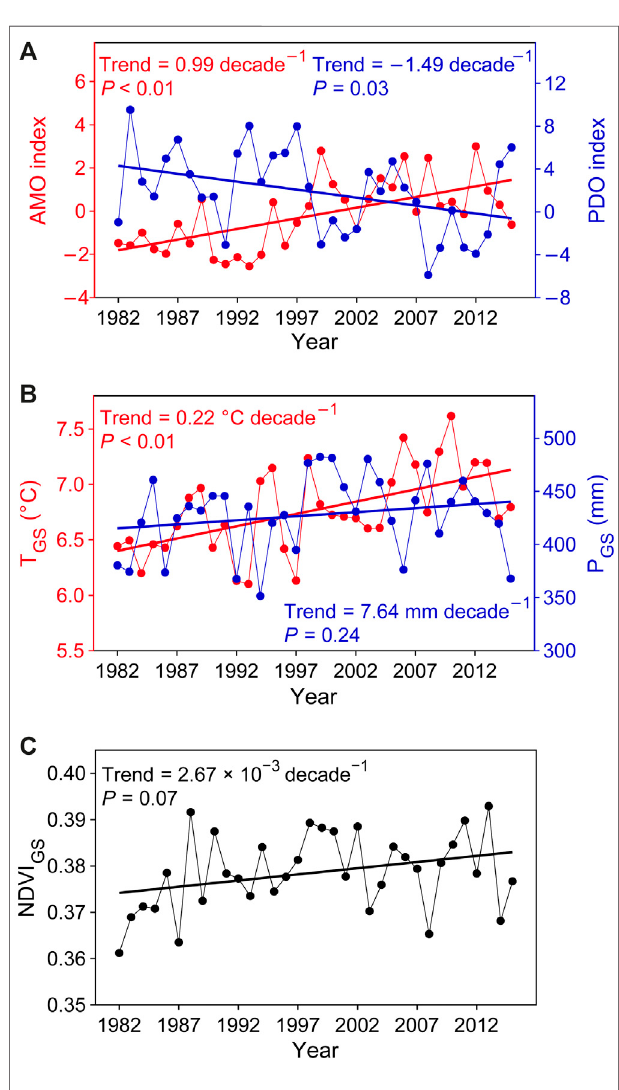
FIGURE 3 | Temporal trends of AMO and PDO indices (A) ; regionally averaged T GS and P GS (B) ; and NDVI GS (C)